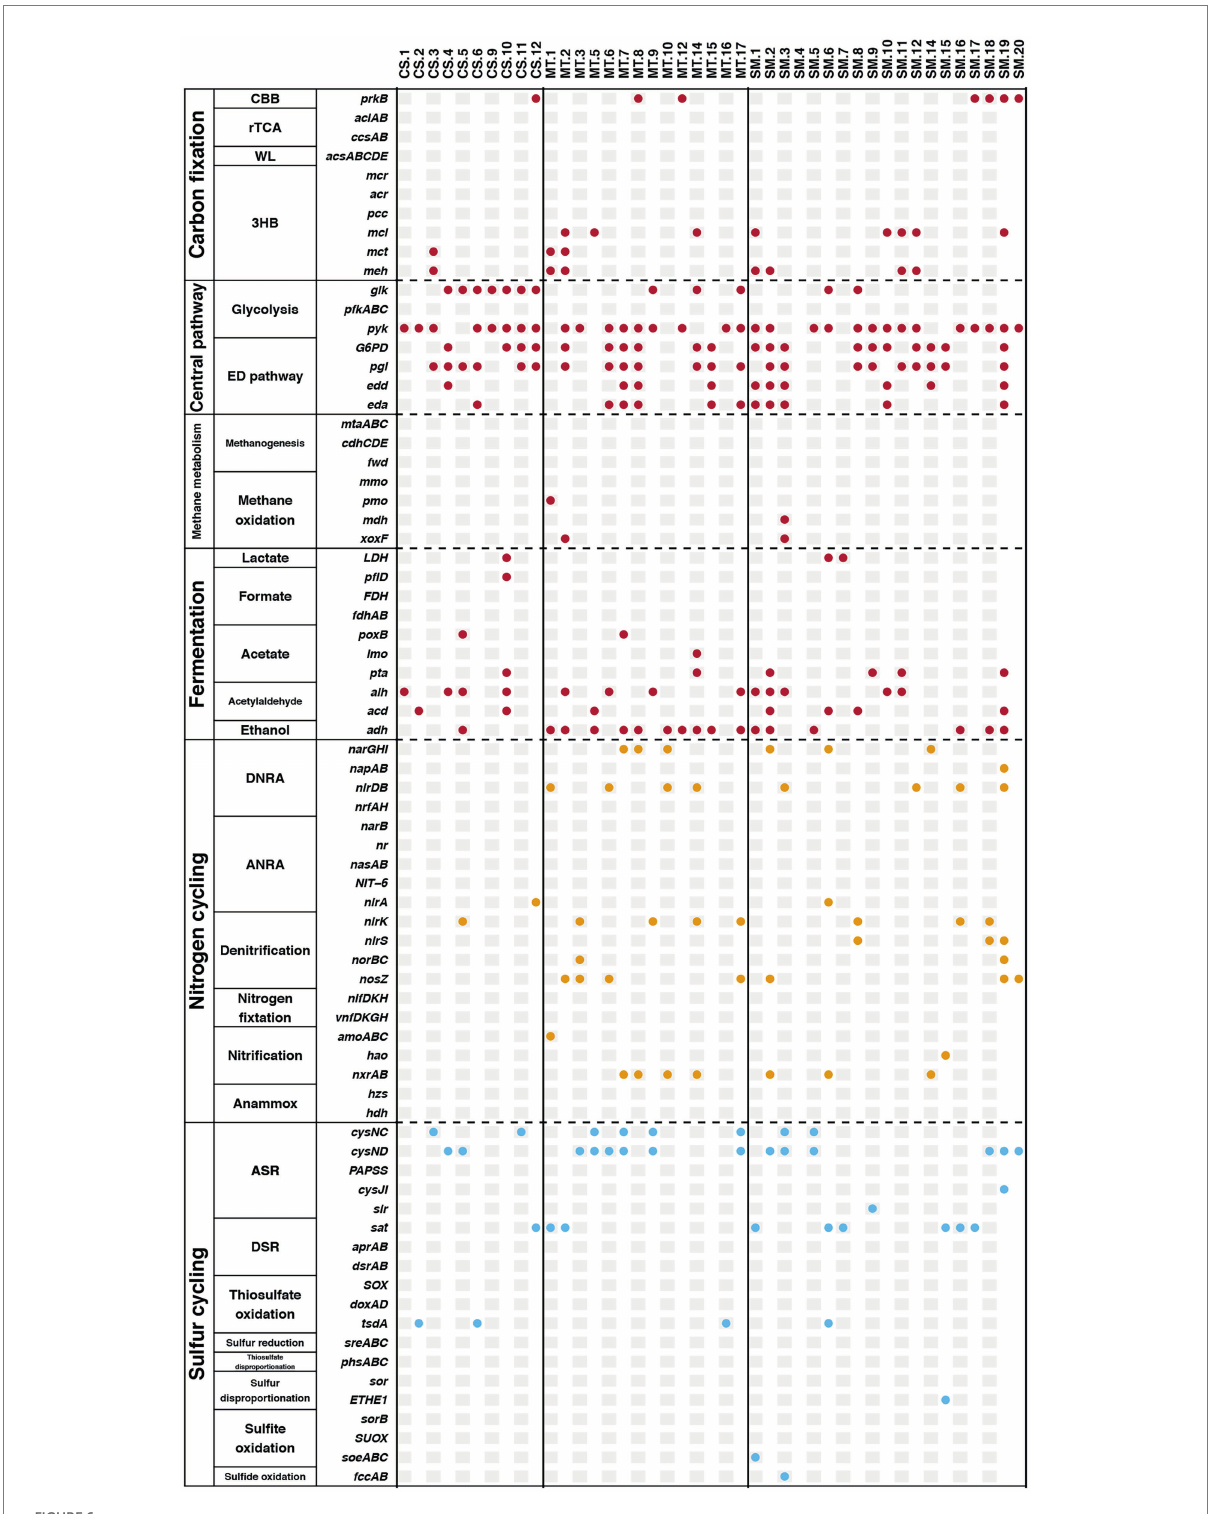
FIGURE 6 The presence of specific genes related to biogeochemical cycling of carbon (red), nitrogen (yellow), and sulfur (blue) in retrieved